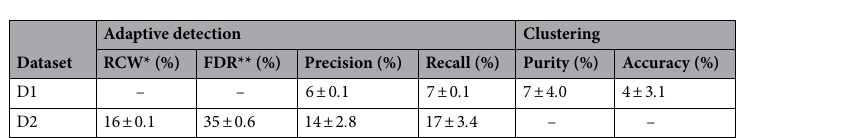
Figure 7. Evaluation of MSTD and MTD using neural recording sessions of the third dataset. ( a ) Three samples of recording sessions. The waveforms that are detected as noise by statistical filtering are illustrated by red stars and the other waveforms by blue circles. ( b ) Investigating the quality of clustering using three blind metrics that do not need any ground truth. In the SSE criterion (left), MSTD outperforms MTD, while in Davies-Bouldin criterion (middle) there exists no significant difference; however, in terms of Calinski-Harabasz criterion, MTD is better. ( c ) The histogram of the number of clusters determined automatically by each method. ( d ) Comparison of automatic spike sorting method with the manual one. The absolute difference between the number of clusters determined automatically by MTD or MSTD and manual sorting (left). The histogram of the percent of the waveforms that are considered as noise both by statistical filtering and manual sorting (right).